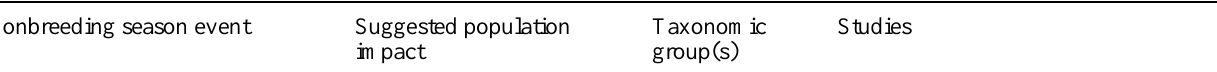
Table 3 . Examples of human-induced nonbreeding impacts on population dynamics of diverse seasonal migrants, as suggested by empirical